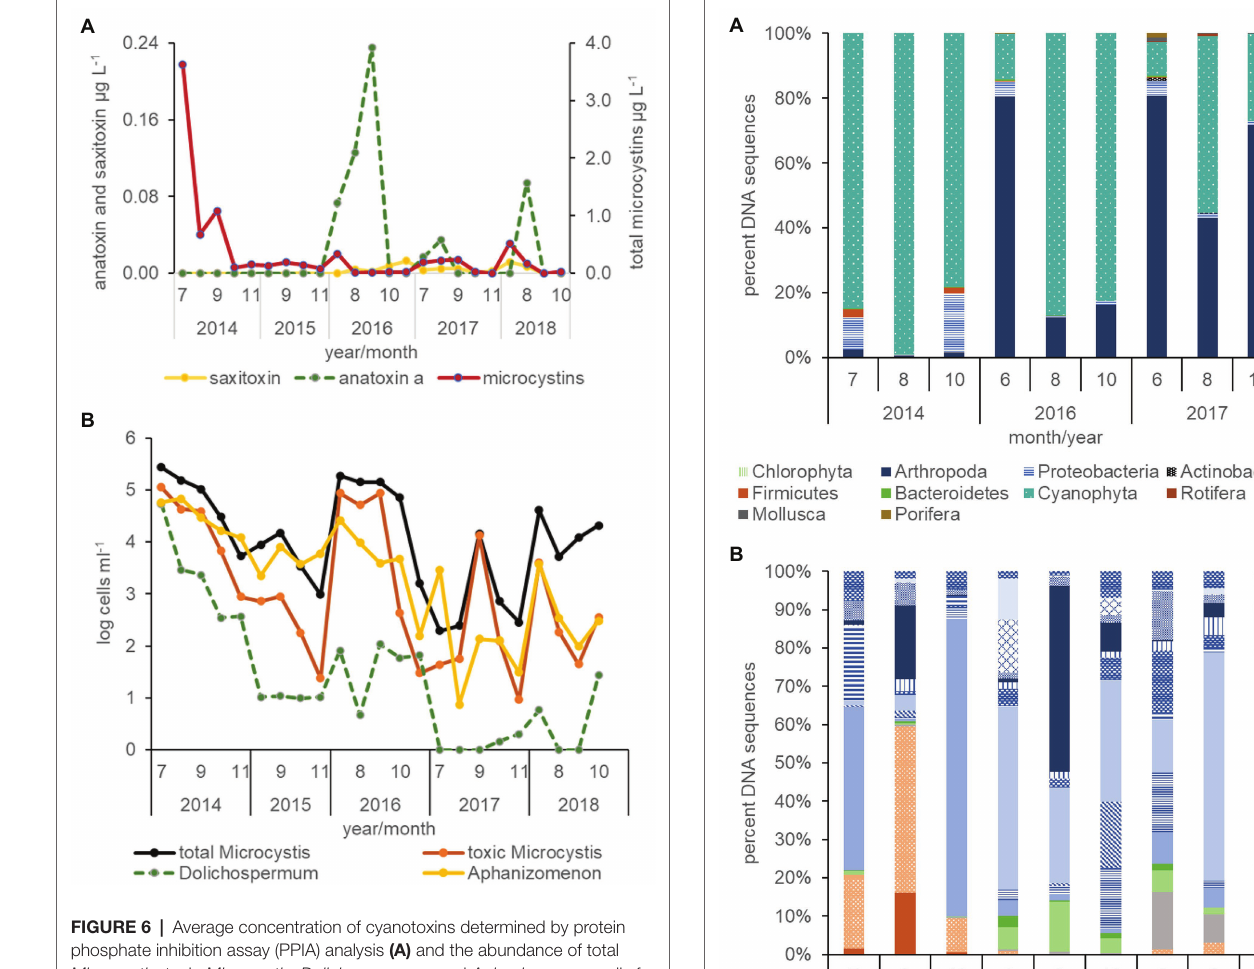
FIGURE 7 | Percent DNA sequences of phyla for non-photosynthetic bacteria (Proteobacteria, Firmicutes, Bacteroidetes, and Actinobacteria), phytoplankton (Chlorophyta), cyanobacteria (Cyanophyta), zooplankton (Arthropoda and Rotifera), mollusks (Mollusca), and sponges (Porifera; A ), and the percent of DNA sequences of non-photosynthetic bacteria genera (B) computed from surface samples collected during the summer and fall of 2014, 2016, and 2017. Letter codes and colors indicate the phyla for each bacterium: Proteobacteria (P, blue), Firmicutes (F, orange), Actinobacteria (A, gray), and Bacteroidetes (B, green). The other Proteobacteria category contains Proteobacteria that summed less than 5% of the total count each